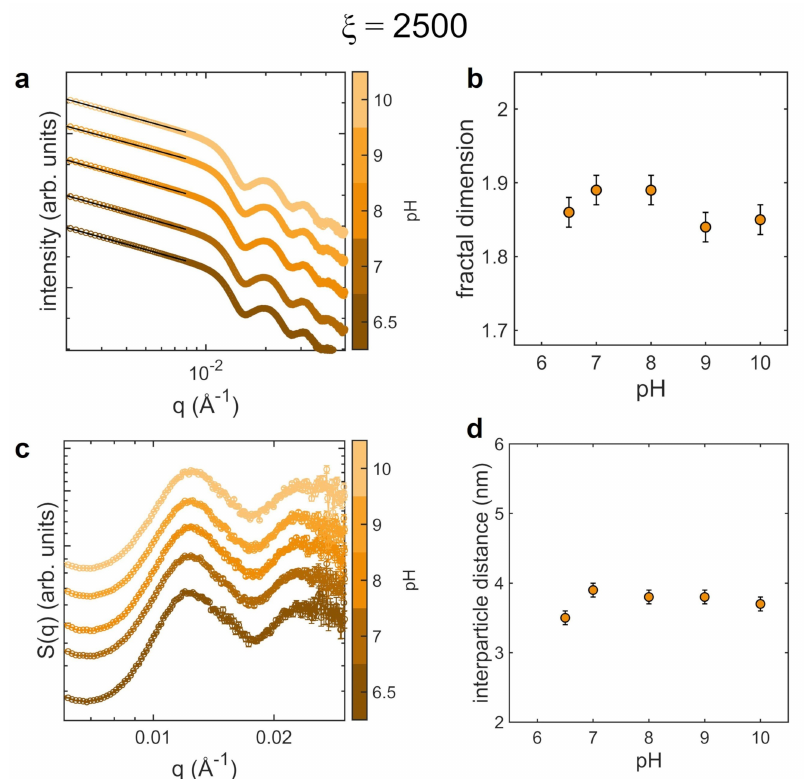
Figure 4. SAXS analysis of the AuNPs clusters morphology as a function of pH in basic conditions (pH between 6.5 and 10), performed at 25 °C for ξ = 2500. ( a ) SAXS curves (circles) and power-law decay fitting curves (black lines); ( b ) fractal dimension as a function of pH; ( c ) structure factors; ( d ) interparticle distance as a function of pH. SAXS curves and structure factors are shifted vertically for